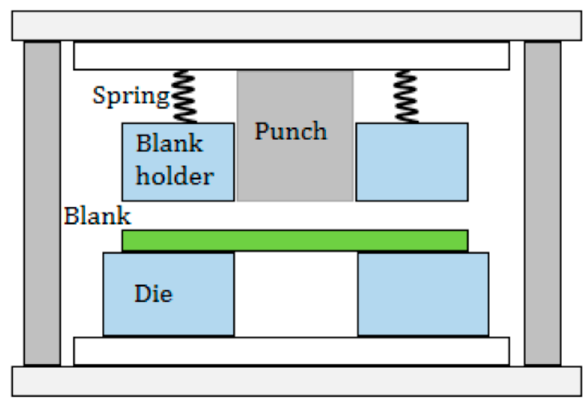
Figure 1. Schematic of blank material in general-purpose die (punch die set) which is installed in the universal tension and compression testing machine for the punching experiments with the various punch-die clearances.